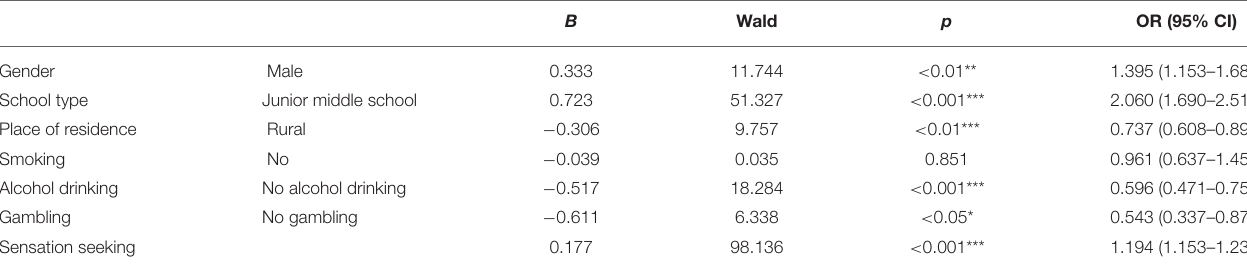
TABLE 3 | Logistic regressions associating with extreme sports participation rate, sensation seeking, smoking, drinking alcohol, and